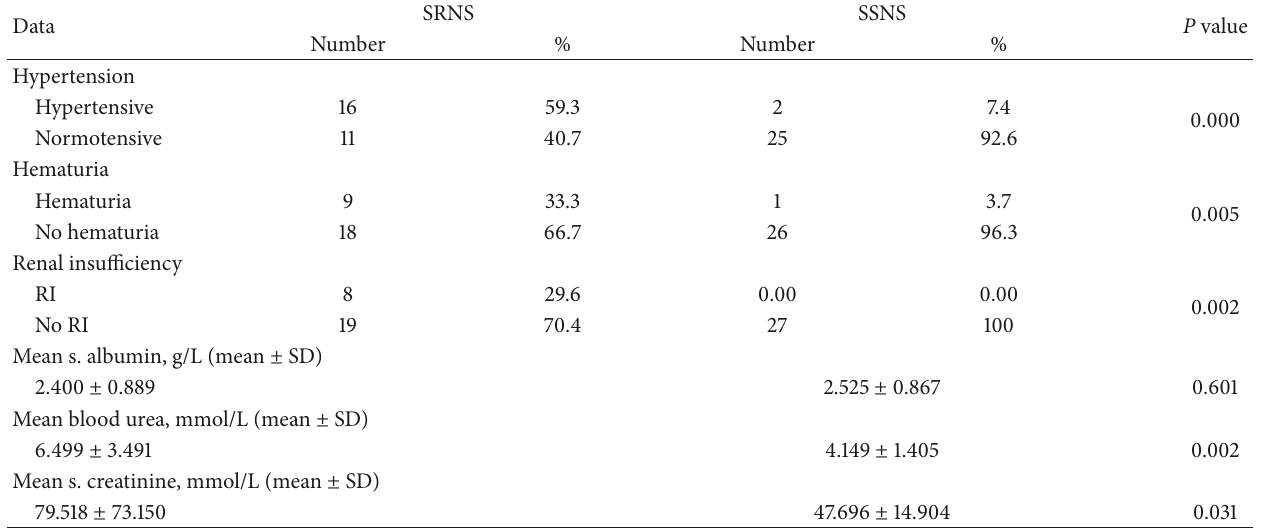
Table 2: Patient distribution according to clinical data and laboratory investigations.